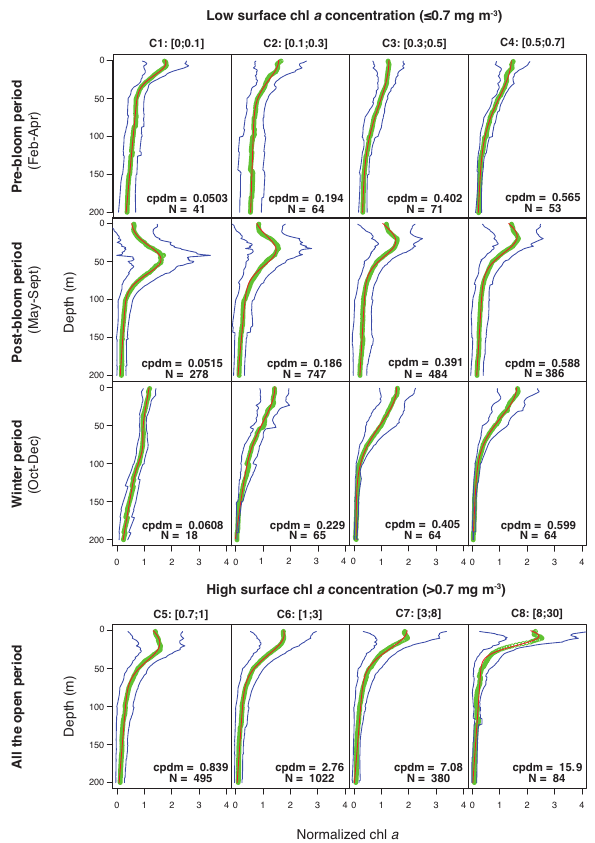
Fig. 5. Average dimensionless chlorophyll a (Chl a ) profiles (green lines) obtained for each category (C1–C8) during pre-bloom, post- bloom, and winter periods as well as over the open water period (i.e., when surface Chl a > 0.7mgm − 3 ) at deep ( > 50m) Arctic stations. Red and blue lines represent the parameterized vertical Chl a profiles and standard deviation, respectively. N and cpdm represent the number of stations and the averaged Chl a surf value, respectively.